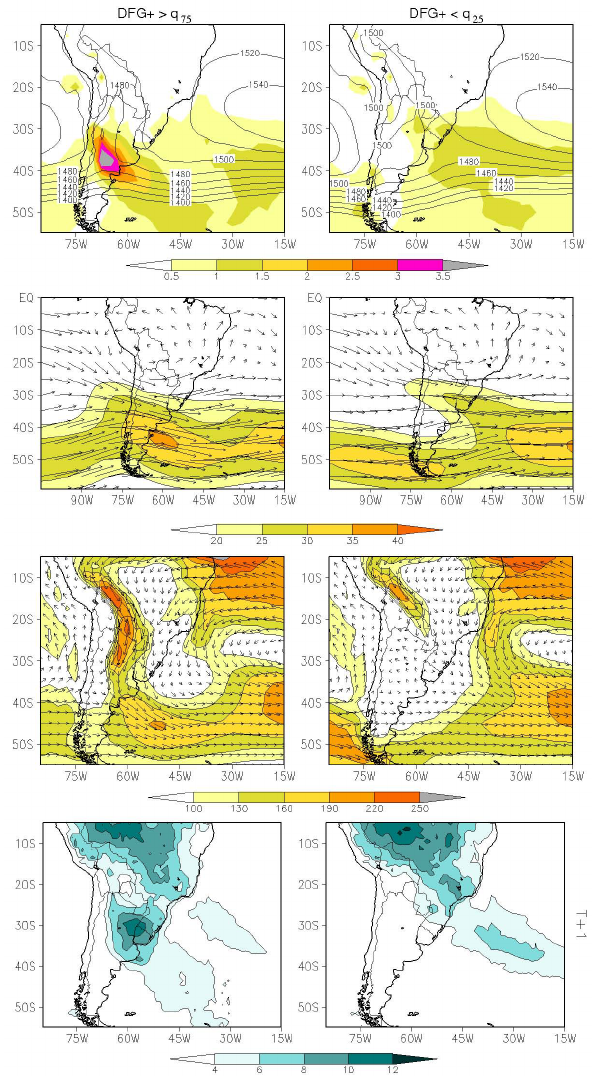
Fig. 2. Composites for cases with DFG + >q 0 . 75 (left) and DFG + <q 0 . 25 (right) are shown. From top to bottom, the panels show geopotential height (m) and FG 3 (K / 100km / day) at 850hPa, wind vectors and its magnitude (m / s) at 250hPa, vertically inte- grated humidity transport and its magnitude (kg/m/s), and precipi- tation (mm/day) with 1-day